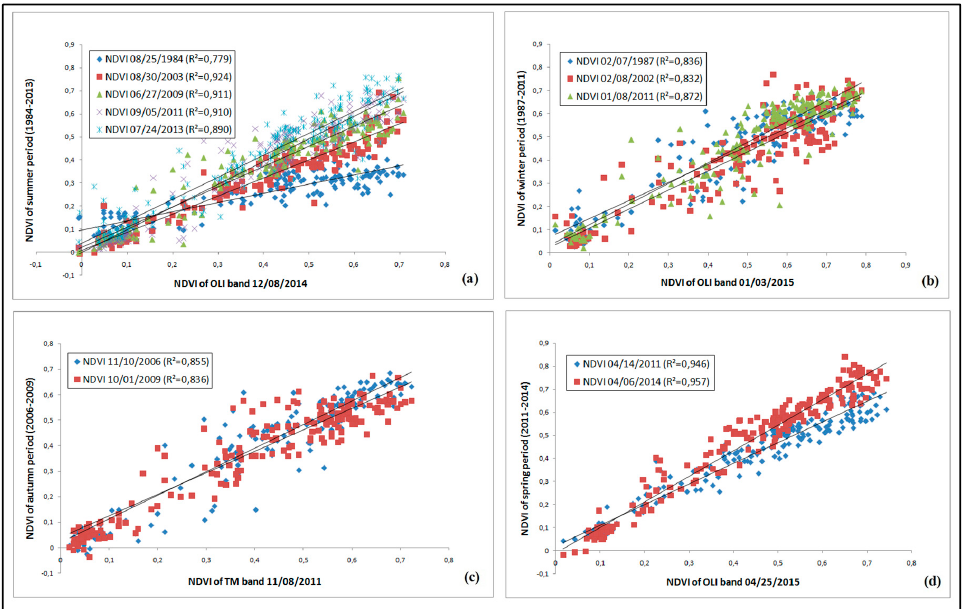
Figure 3. Inter-calibration of NDVI extracted from Landsat imageries according to the seasons: ( a ) summer inter-calibration of NDVI; ( b ) winter inter-calibration of NDVI; ( c ) autumn inter-calibration of NDVI; and ( d ) spring inter-calibration of NDVI.